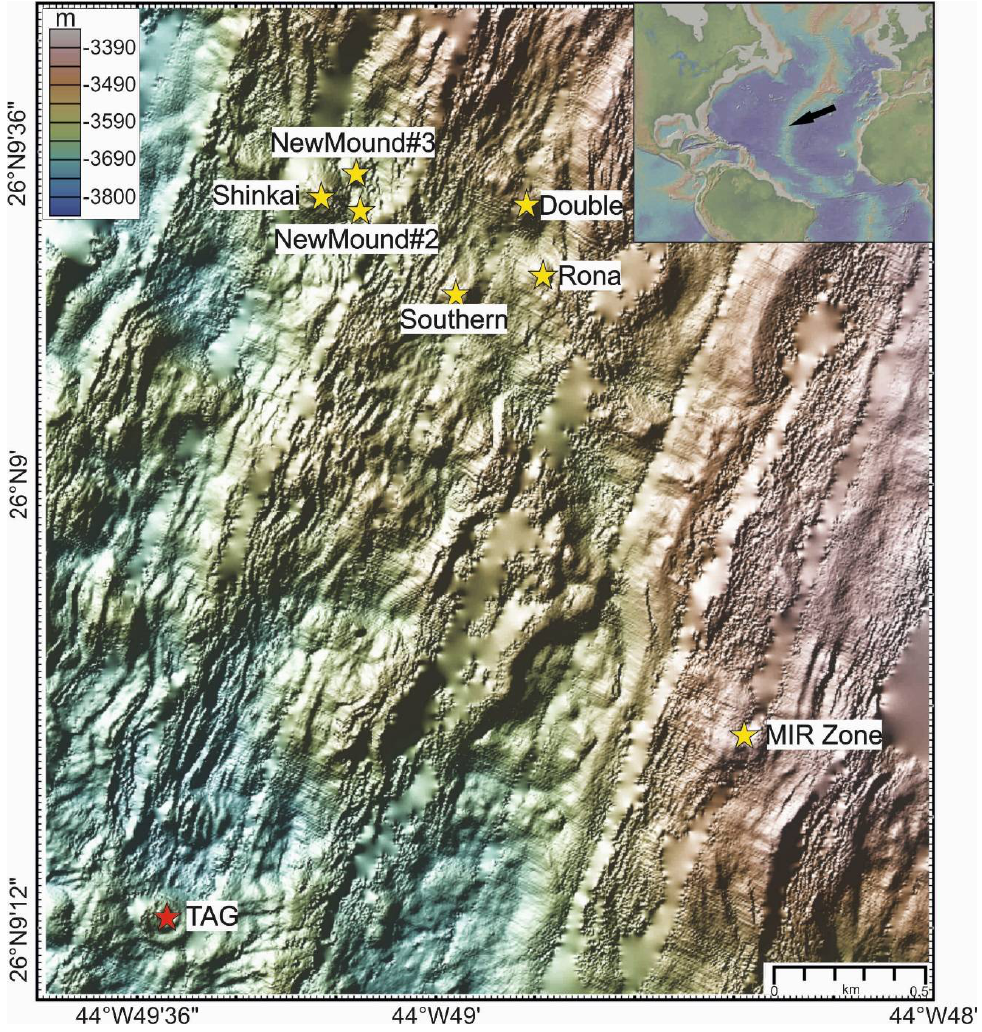
Figure 1. Bathymetric map (data source GeoMapApp: KN142-05 (TAG94), DSL120 2 m grid White) of the Trans-Atlantic Geotraverse (TAG) hydrothermal area and the location of the active and inactive hydrothermal sites studied in the Blue Mining project. The inset shows the location on the Mid-Atlantic.